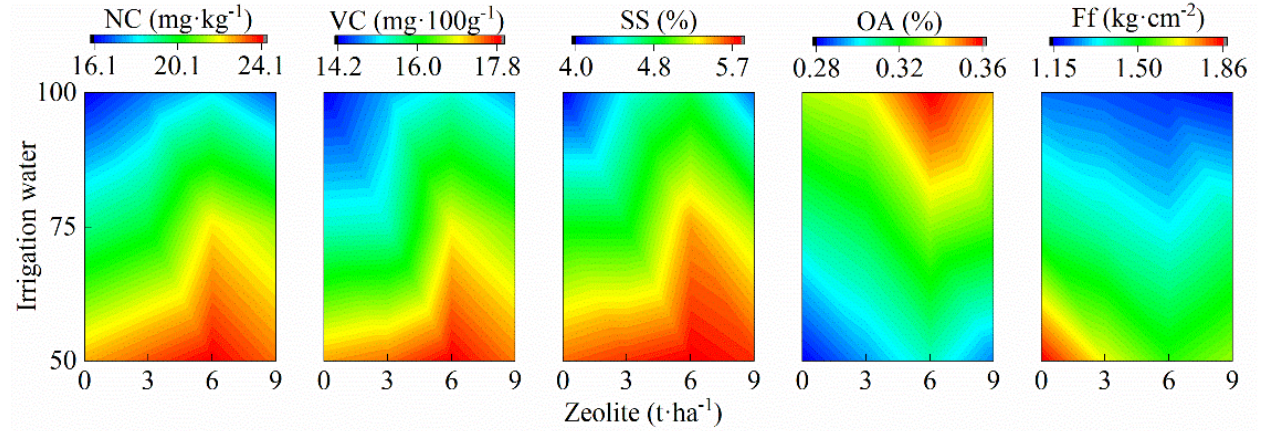
Figure 4. Effects of W-Z on tomato quality during alternate drip irrigation under mulch. NC , VC , SS , OA and Ff represent nitrate, vitamin C, soluble solid, organic acid, and fruit firmness, respec ‐ tively.